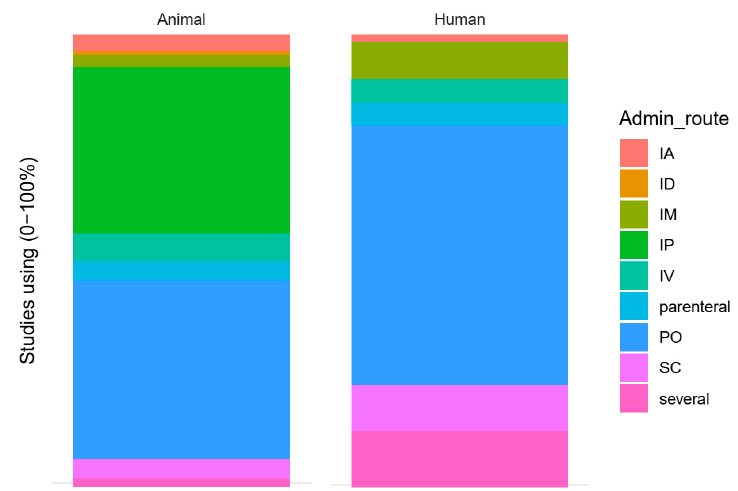
Figure 12. Route of administration for included animal and human studies. IA: Intra-articular; ID: